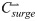
The population vector decoder (PVD) model used and its predictions.(A) The model in graphical form for a stimulus heading, θ
s, of 45° to the right. This 45° vector can be represented by orthogonal surge, C⇀surge, and sway, C⇀sway, vectors offset by φ. The perceived heading, θ
p, is the sum of the surge and sway vectors after the sway component is multiplied by r. (B) The quantitative predictions of the model when r = 2 (sway component weighted twice that of surge). The solid blue tracing represents a 27° leftward gaze and the dashed red tracing represents a 27° rightward gaze. Ideal performance would be a perceived heading error of 0° for all reference headings. The model predicts a gaze shift changes the coordinate system and influences both the phase and offset of the perceived heading error.